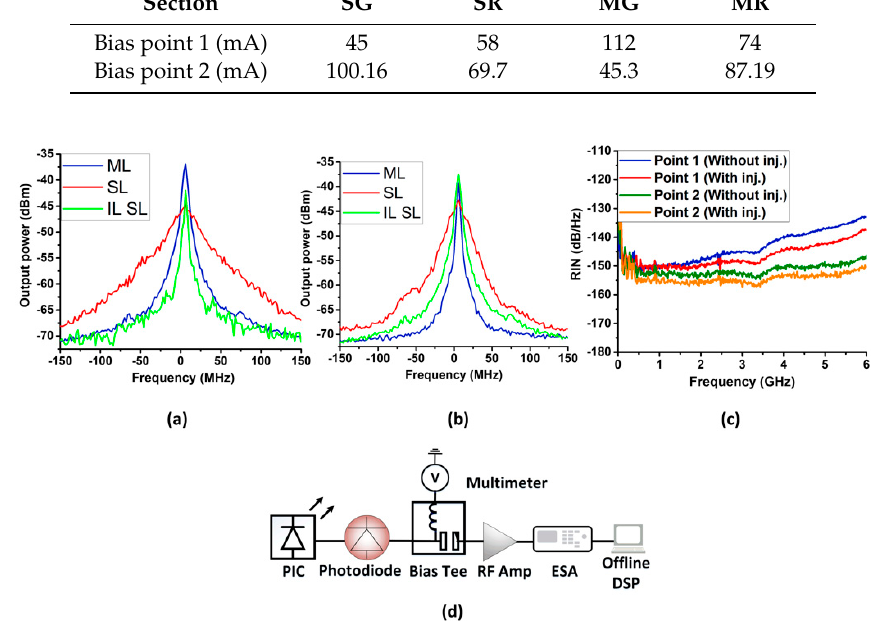
Figure 5. ( a ) Electrical spectra of the measured linewidth of master laser (ML), slave laser (SL) and injection-locked slave laser (IL SL) the master laser for bias point 1 in Table 3; ( b ) same for bias point 2 in Table 3; ( c ) RIN values for bias points 1,2 in Table 4 with (red, orange) and without injection (blue, green) and ( d ) RIN measurement setup diagram. Table 4. Bias points for RIN measurements.